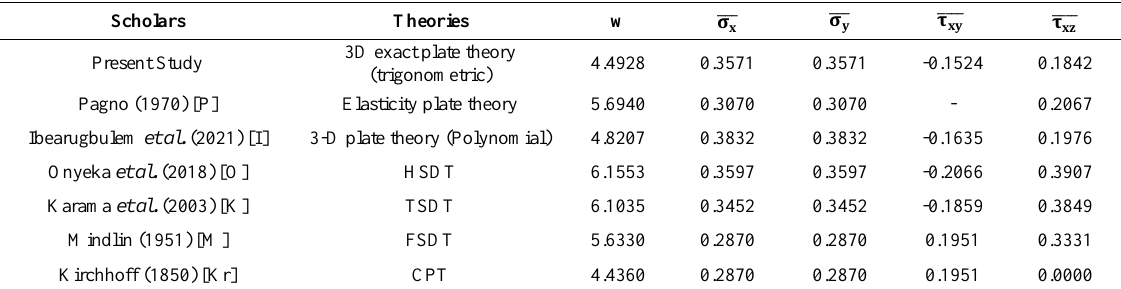
Table 2. Non dimensional forms of displacement and stresses of SSSS plate at aspect ratio b/a = 1. 0 and